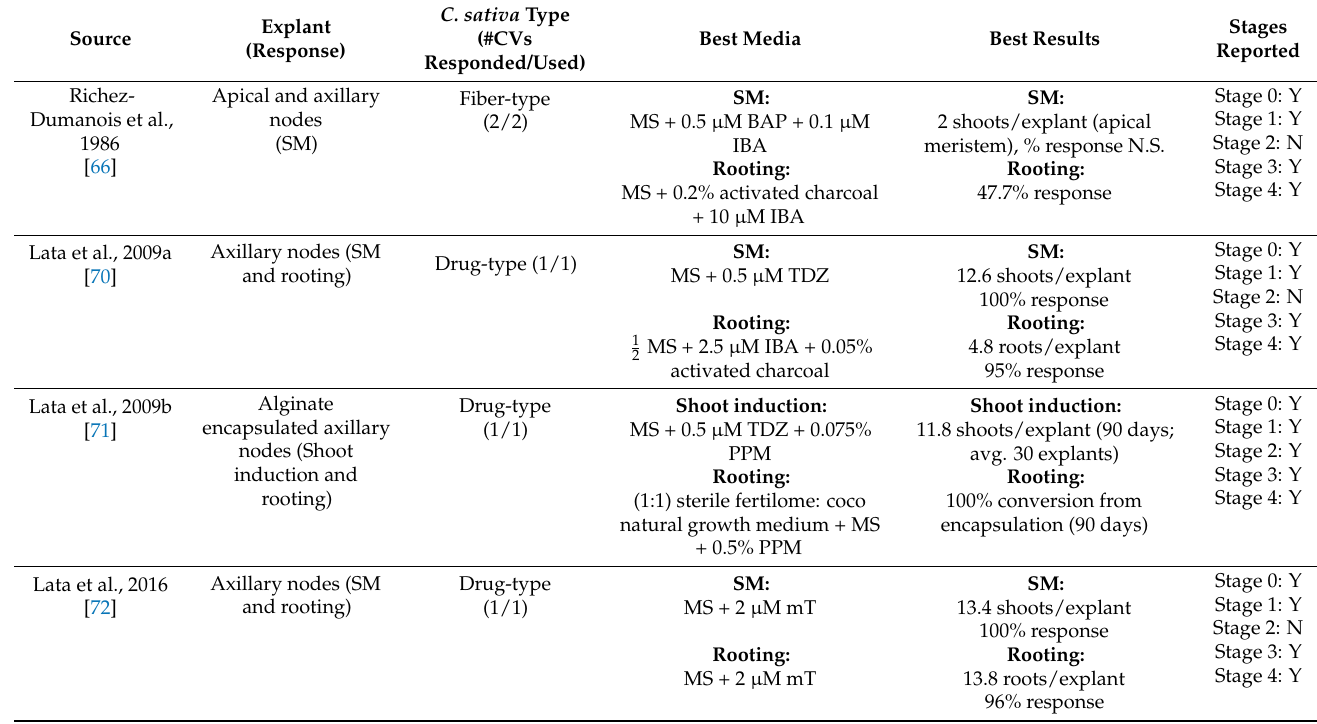
Figure 4. The five-stage micropropagation process for tissue culture. The red arrow is indicative of the 1-3-4 approach (where Stage 2 is skipped). Stage 2 is commonly skipped in C. sativa micropropagation methods due to the plant’s recalcitrance to long-term culture characterized by a slow decline in fitness. Inclusion of Stage 2 allows for repeated subcultures of In Vitro plants (indicated by the circular arrows), therefore facilitating large-scale multiplication or long-term germplasm storage. Table 1. Summary of the published micropropagation studies on C. sativa. The table summarizes studies that rely on shoot multiplication (SM) to increase explant number. SM refers to the proliferation of multiple shoots from an existing meristem, such as axillary or apical nodes and floral meristems. Cannabis type is defined in this table as either psychoactive “drug-type” ( Cannabis ; tetrahydrocannabinol (THC) > 0.3% in flowering head) or known industrial hemp genotypes “fiber-type” (Hemp; THC < 0.3% in flowering head). A breakdown of the cultivars (CVs) used in the study and the number which responded to the treatment are included for each study. N.S. Not specified is assigned to data that were not specified, instances of “data not shown”, or when data are omitted in the original research